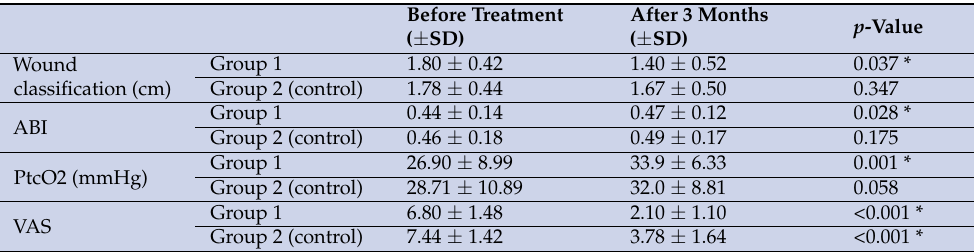
Table 1. Gene therapy outcomes.